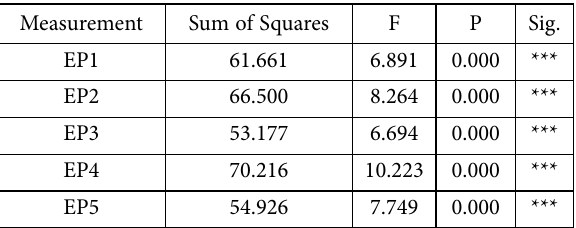
Table 14. One–way analysis of variance of environmental policy Measurement